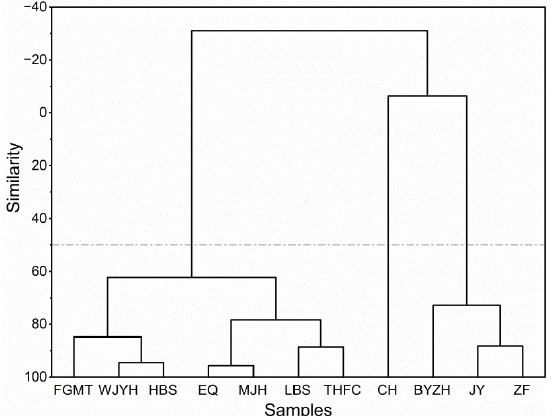
Figure 4. Dendrogram from HCA of flower essential oils of the eleven woody peony cultivars ( Paeonia × suffruticosa Andr.). Clustering is based on similarity under Ward linkage and squared Euclidean distance. For codes of cultivar names, see Table 1.